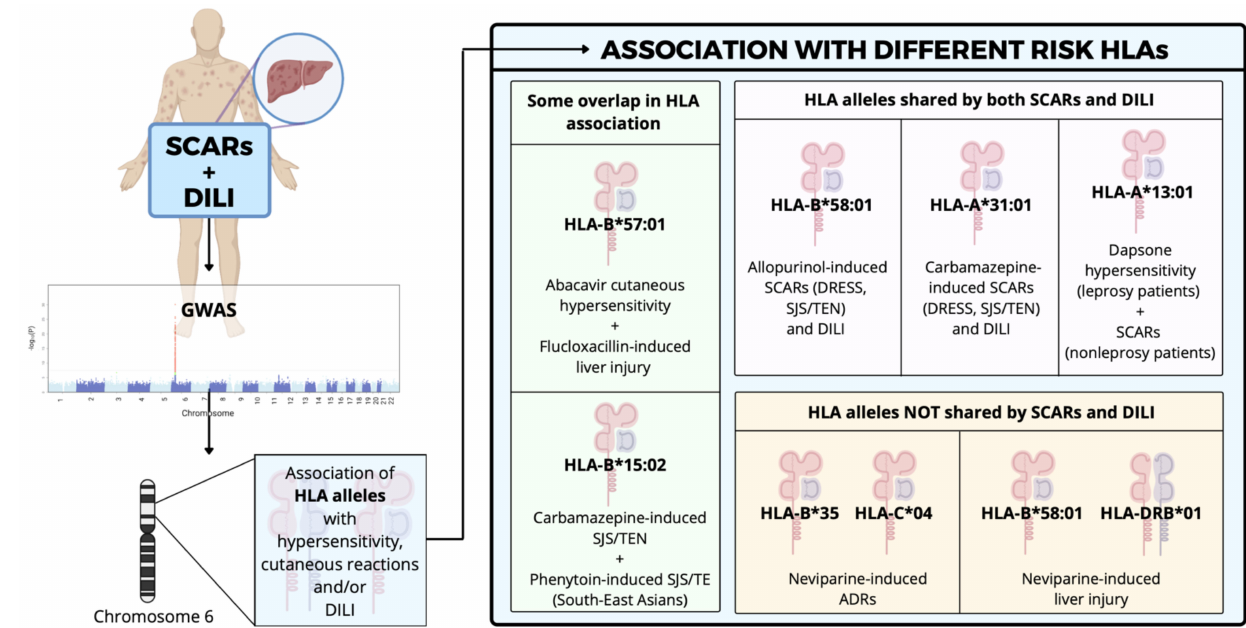
Figure 2. Different GWAS-determined HLA alleles linked to the risk of developing ADRs. There are three main types of associations: Some overlap in HLA associations, where the same allele is linked to the risk of developing ADR due to different drugs (green boxes); HLA alleles that are shared by both SCARs and DILI and trigger both ADRs (pink boxes); and HLA alleles not shared by SCARs and DILI, where different ADRs due to the same drugs are linked to different HLA alleles (orange boxes). DILI, Drug-Induced Liver Injury; SCAR, Severe Adverse Cutaneous Reaction; ADR, Adverse Drug Reaction; GWAS, Genome-Wide Association Studies; HLA, Human Leukocyte Antigen; DRESS, Drug Reaction with Eosinophilia and Systemic Symptoms; SJS, Stevens–Johnson Syndrome; TEN, Toxic Epidermal